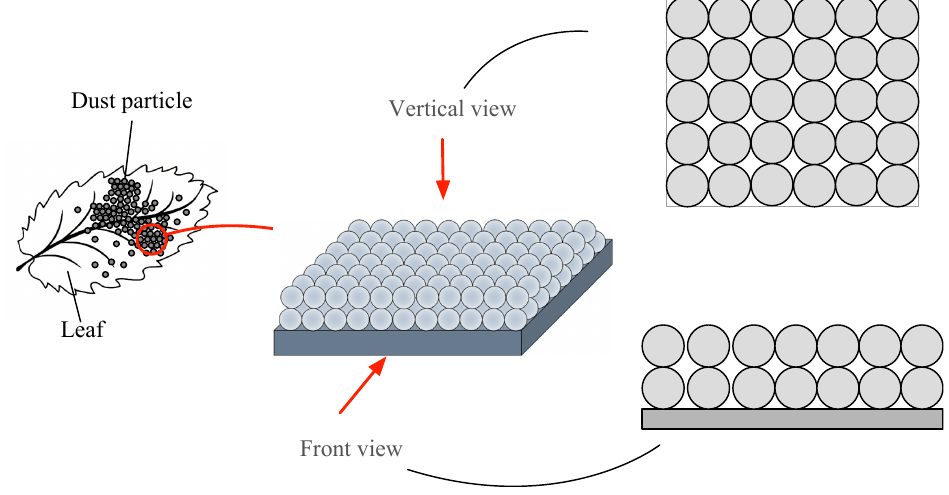
Figure 11. Another arrangement and accumulation mode of dust particles.